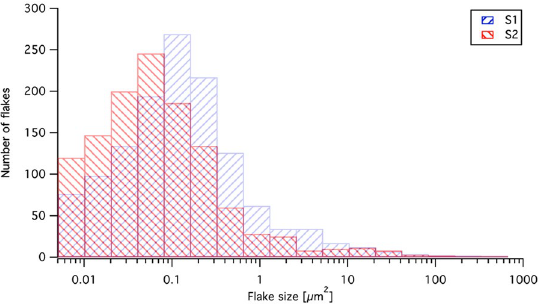
Figure 3. Histogram of the flake size distribution after 10 passes for S1 and S2 from SEM image analysis. The flake size distribution is presented in flake area and the x-axis is logarithmic and the well-width is doubled for each well starting at 0.005 μ m 2 .